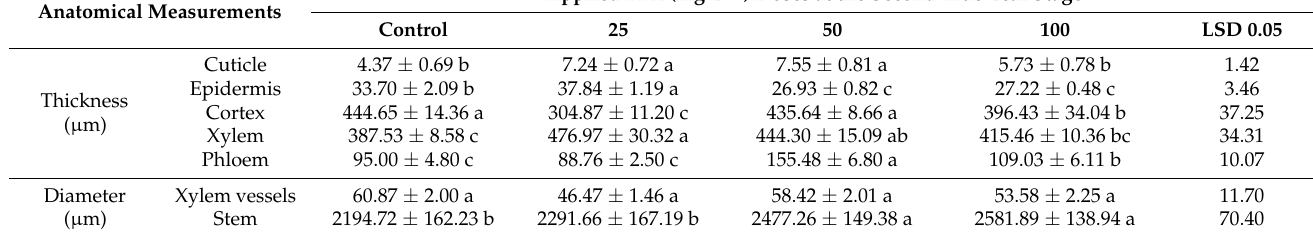
Table 6. Anatomical measurements of tomato stems, as affected by the application of various concentrations of PBZ substance (after 10 days from PBZ application and without infection by Alternaria solani ).